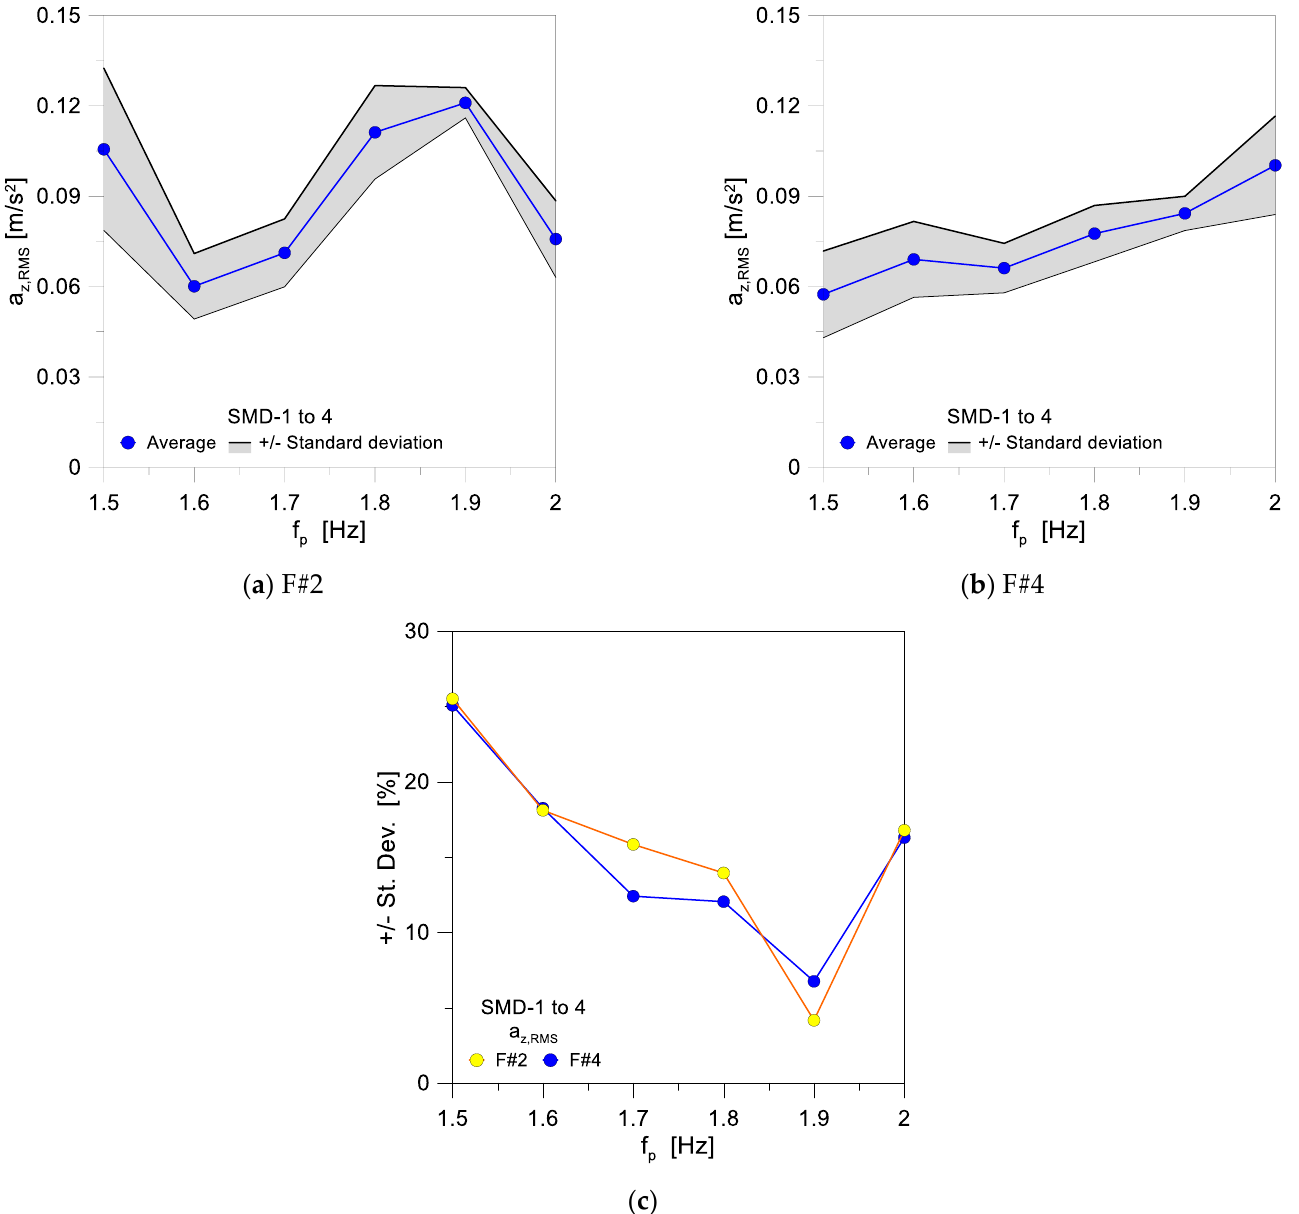
Figure 12. Sensitivity of RMS acceleration to selected SMD pedestrian models (with M = 80 kg) for floor systems: ( a ) F#2 (concrete) and ( b ) F#4 (glass) configurations, with ( c ) trend of percentage scatter for both systems (ABAQUS).